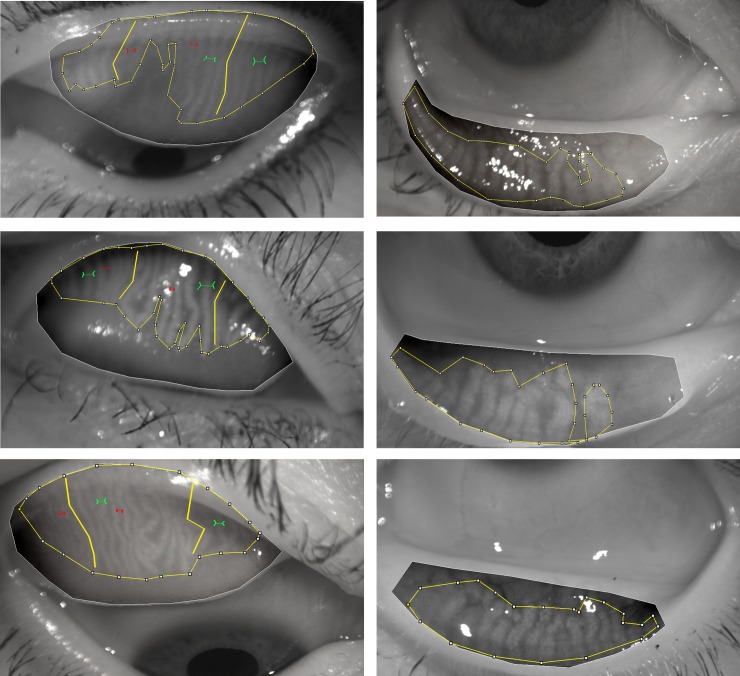
Computer-assisted analysis of meibomian gland (MG) morphology.The MG length, thickness, and gap are marked as thick yellow line, green line, and red lines, respectively. The photos in the left column show MG loss in the upper eyelids of three eyes of 58.2%, 57.8%, and 67.9%, from top to bottom, respectively, whereas the photos in the right column show MG loss in the lower eyelids of the same eyes of 58.6%, 47.1%, and 64.9%, from top to bottom, respectively.